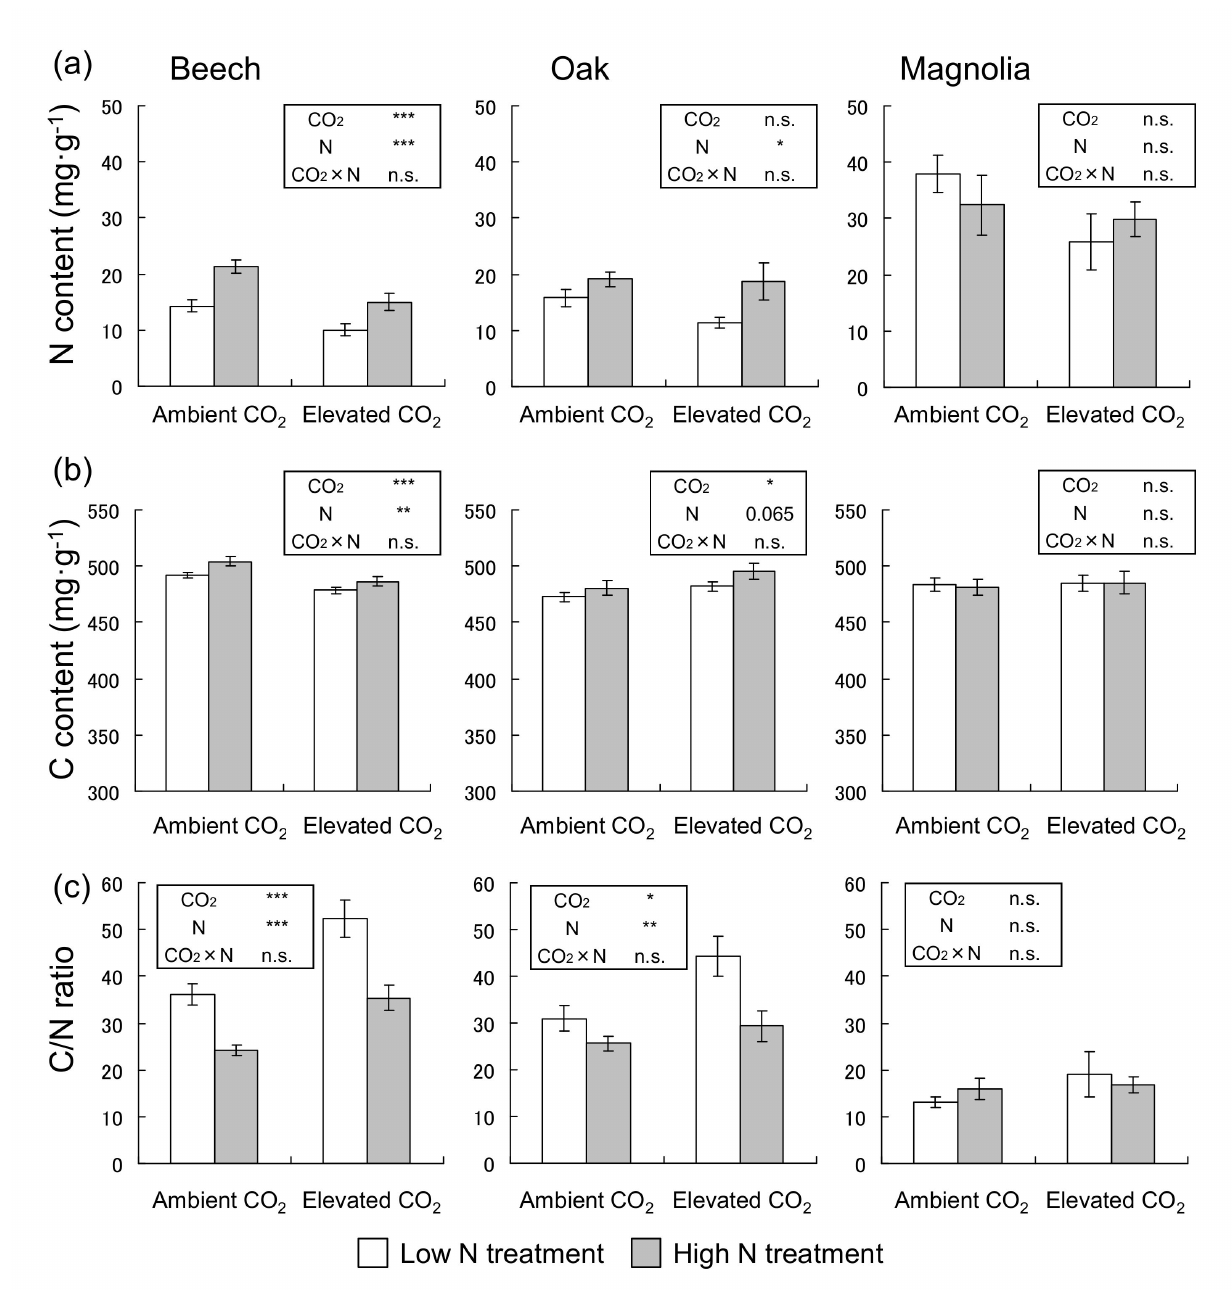
Figure 2. ( a ) Nitrogen content, ( b ) carbon content, and ( c ) C/N ratio in the leaves of seedlings of three tree species at each treatment. Values are expressed as means ± SE (beech n = 12, oak and magnolia n = 6). The results of the two-way ANOVA are also shown (*** p < 0.001, ** p < 0.01, * p < 0.05, n.s. p ≥ 0.1). Actual p values are shown when 0.05 < p < 0.10. n.s.; not